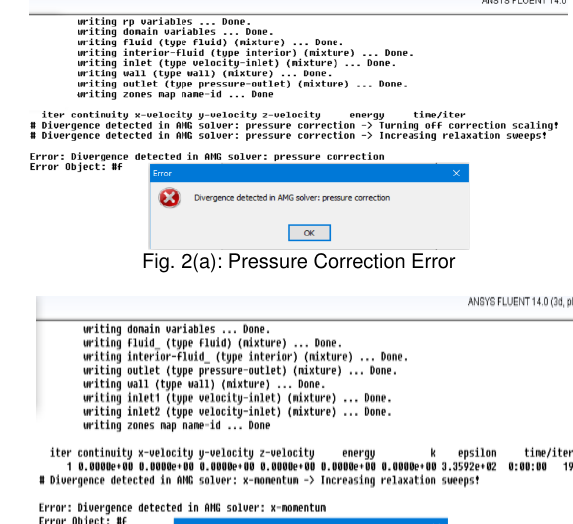
Fig. 2(a): Pressure Correction Error